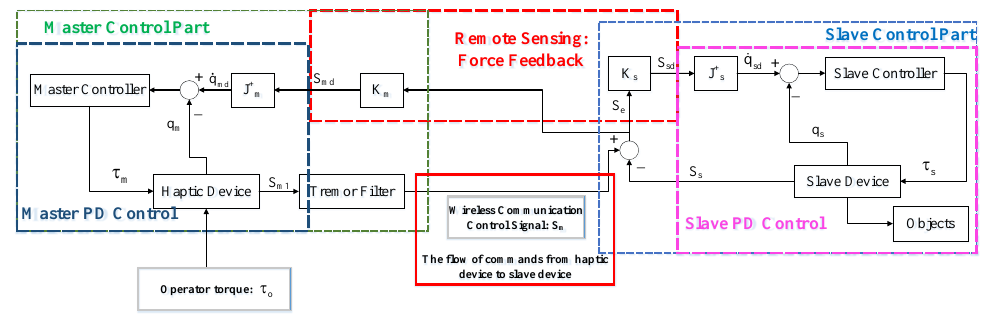
Figure 2. Control mode of